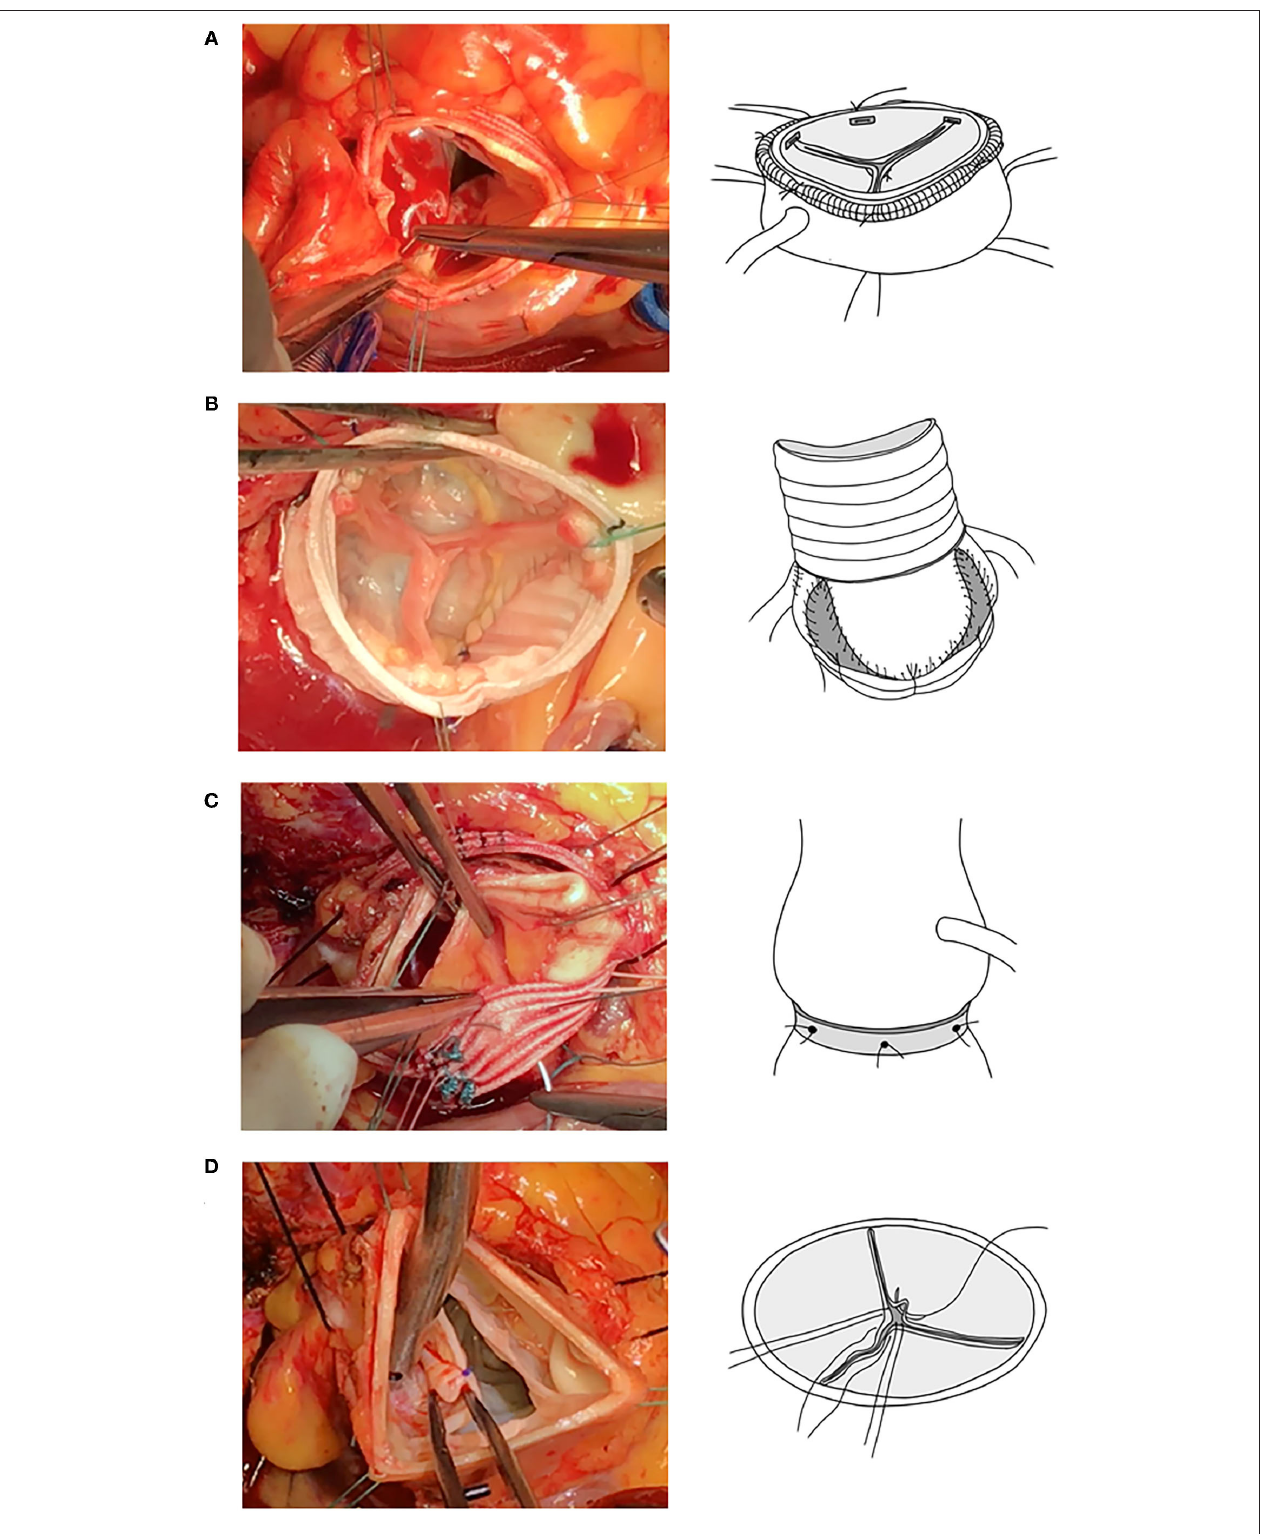
FIGURE 6 | Important current AV repair techniques. From top downward (left column, surgical views; right column, illustrative figures), STJ remodeling (A) , valve sparing root replacement (B) , annuloplasty (C) , and FML central plication (D) . AV, aortic valve; STJ, sino-tubular junction; FML, free margin length.